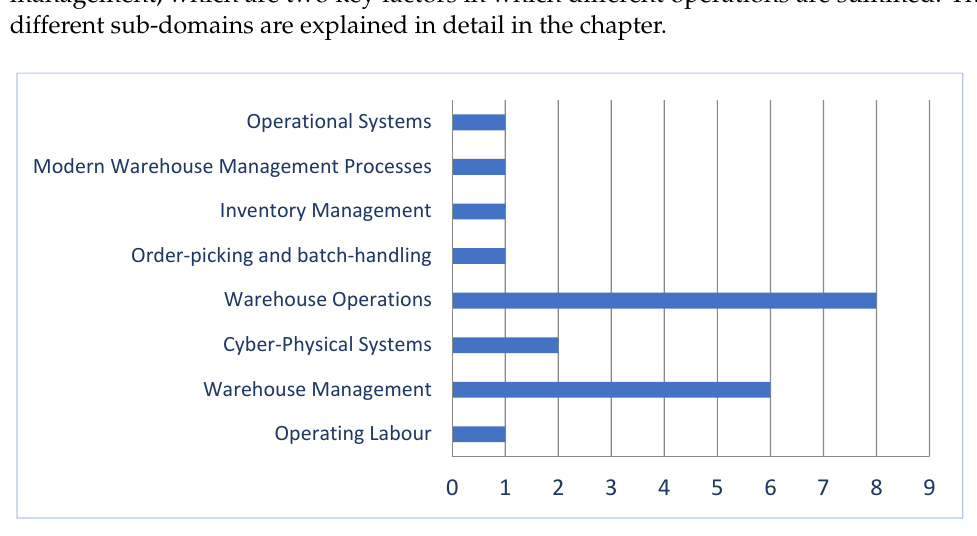
Figure 3. Summary of frequency of sub-domains.